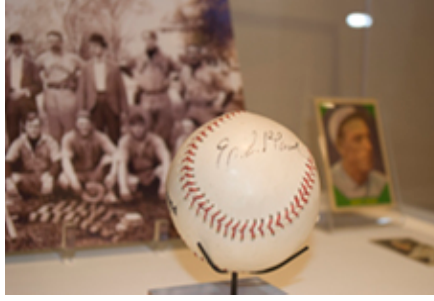
The Eddie Plank baseball, on display in Special Collections, is a popular artiFACT highlighting College history.